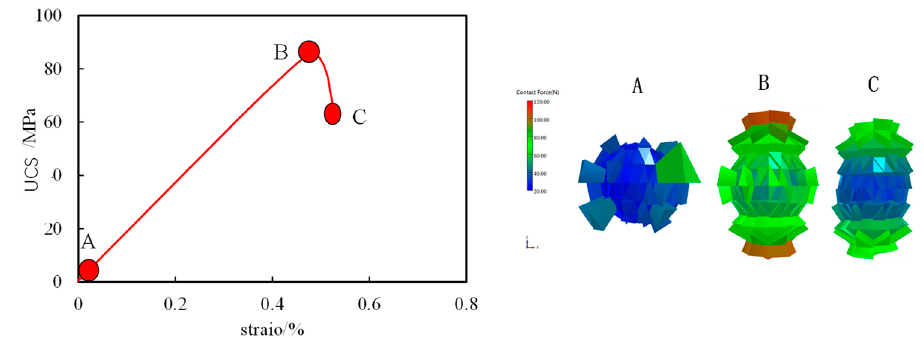
Figure 9. Normal contact force distribution in different states.